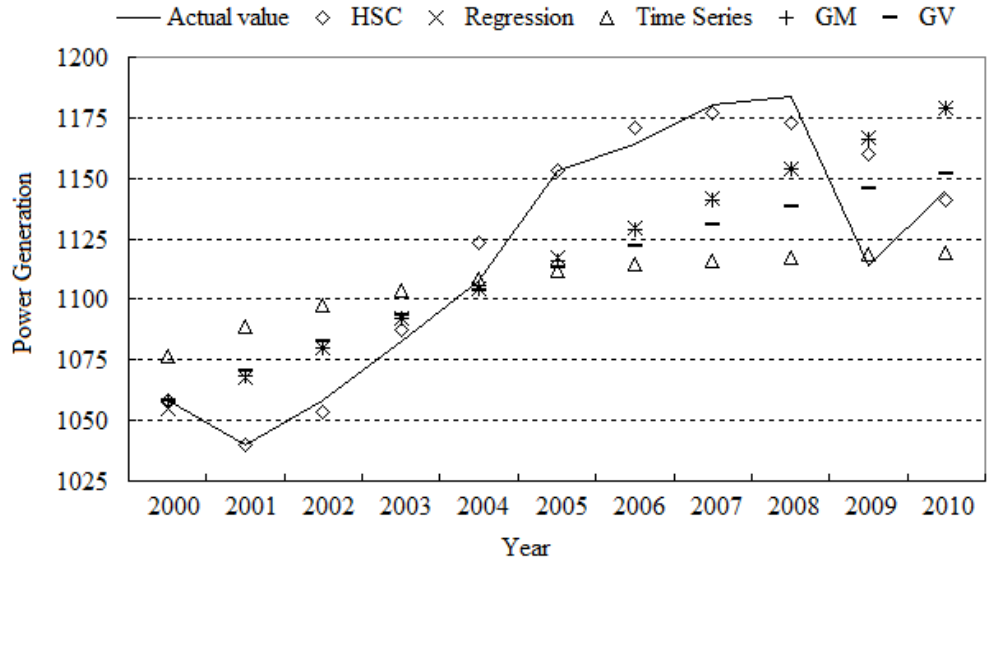
Figure 3. Forecasting performance of the HS-based JPOC model and four other single models for